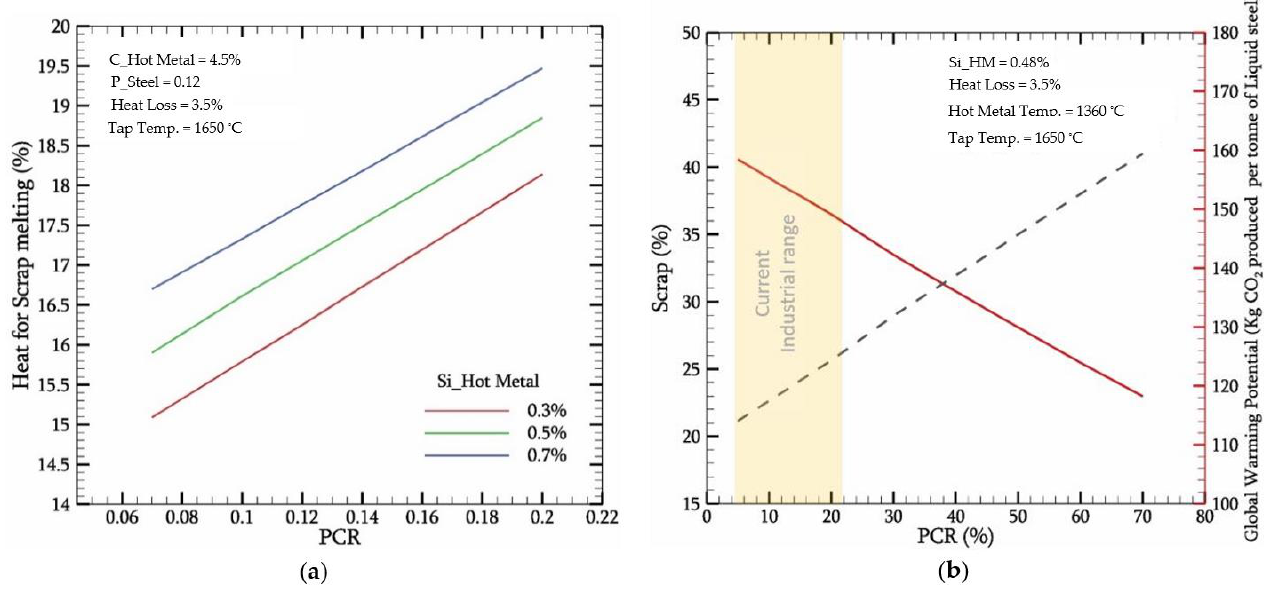
Figure 8. ( a ) Influence of PCR and Si in hot metal (%) on Heat of scrap melting ( b ) Effect of PCR (%) on scrap percentage and global warming potential. on scrap percentage and global warming